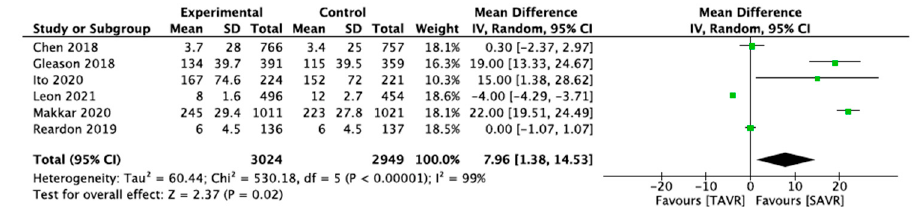
Figure 4. Forest plot of the pooled studies for cardiogenic cause (MI) [18,20,28–30].